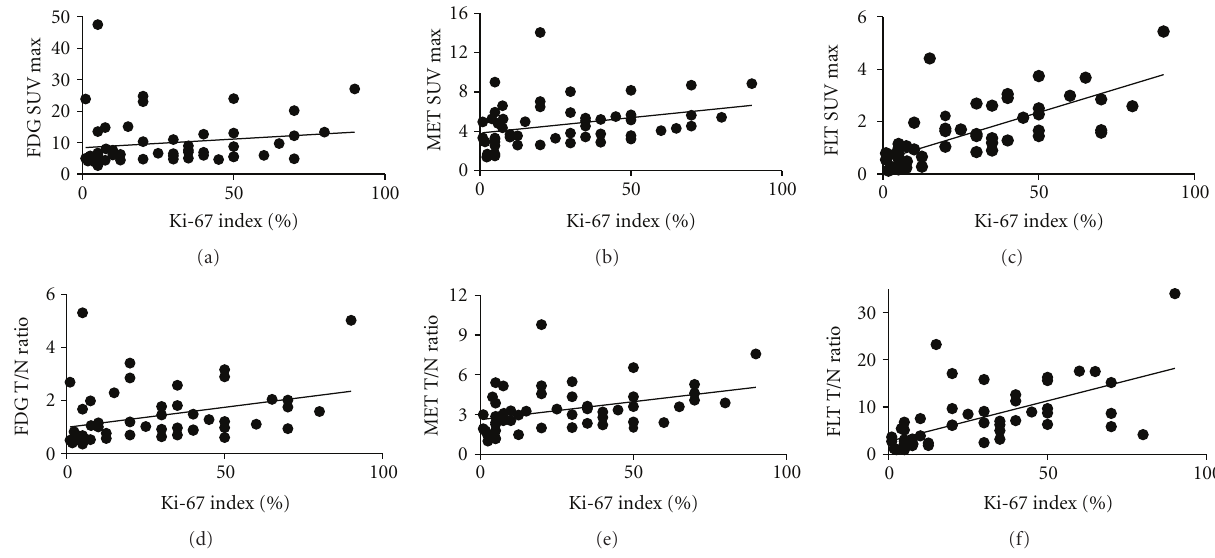
Figure 2: The correlations between SUV max (FDG (a), MET (b), and FLT (c)) and Ki-67 index were determined. Analysis indicates a more significant correlation between the Ki-67 index and FLT SUV max ( r = 0 . 72, P < 0 . 001) than between the index and FDG SUV max ( r = 0 . 16, P = 0 . 24) or MET SUV max ( r = 0 . 32, P = 0 . 02). The correlations between T / N ratio (FDG (d), MET (e) and FLT (f)) and Ki-67 index were determined. Analysis indicates a more significant correlation between the Ki-67 index and FLT T / N ratio ( r = 0 . 63, P < 0 . 001) than between the index and FDG T / N ratio ( r = 0 . 33, P = 0 . 02) or MET T / N ratio ( r = 0 . 39, P < 0 .